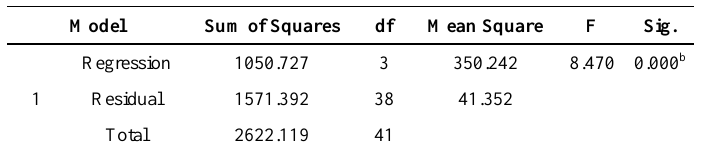
Table 7. The ANOVA Analysis Results